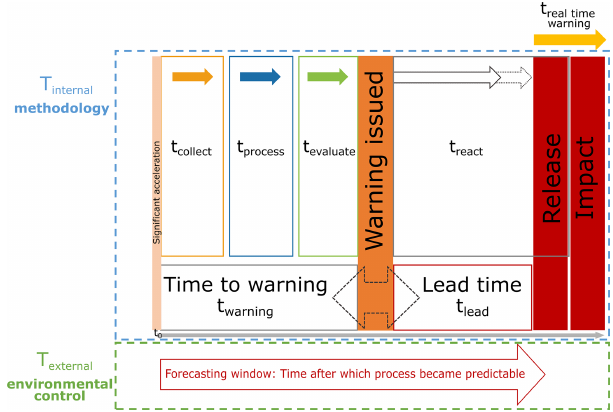
Figure 1. The novel conceptual approach for lead time, time to warning and the forecasting window for optical image